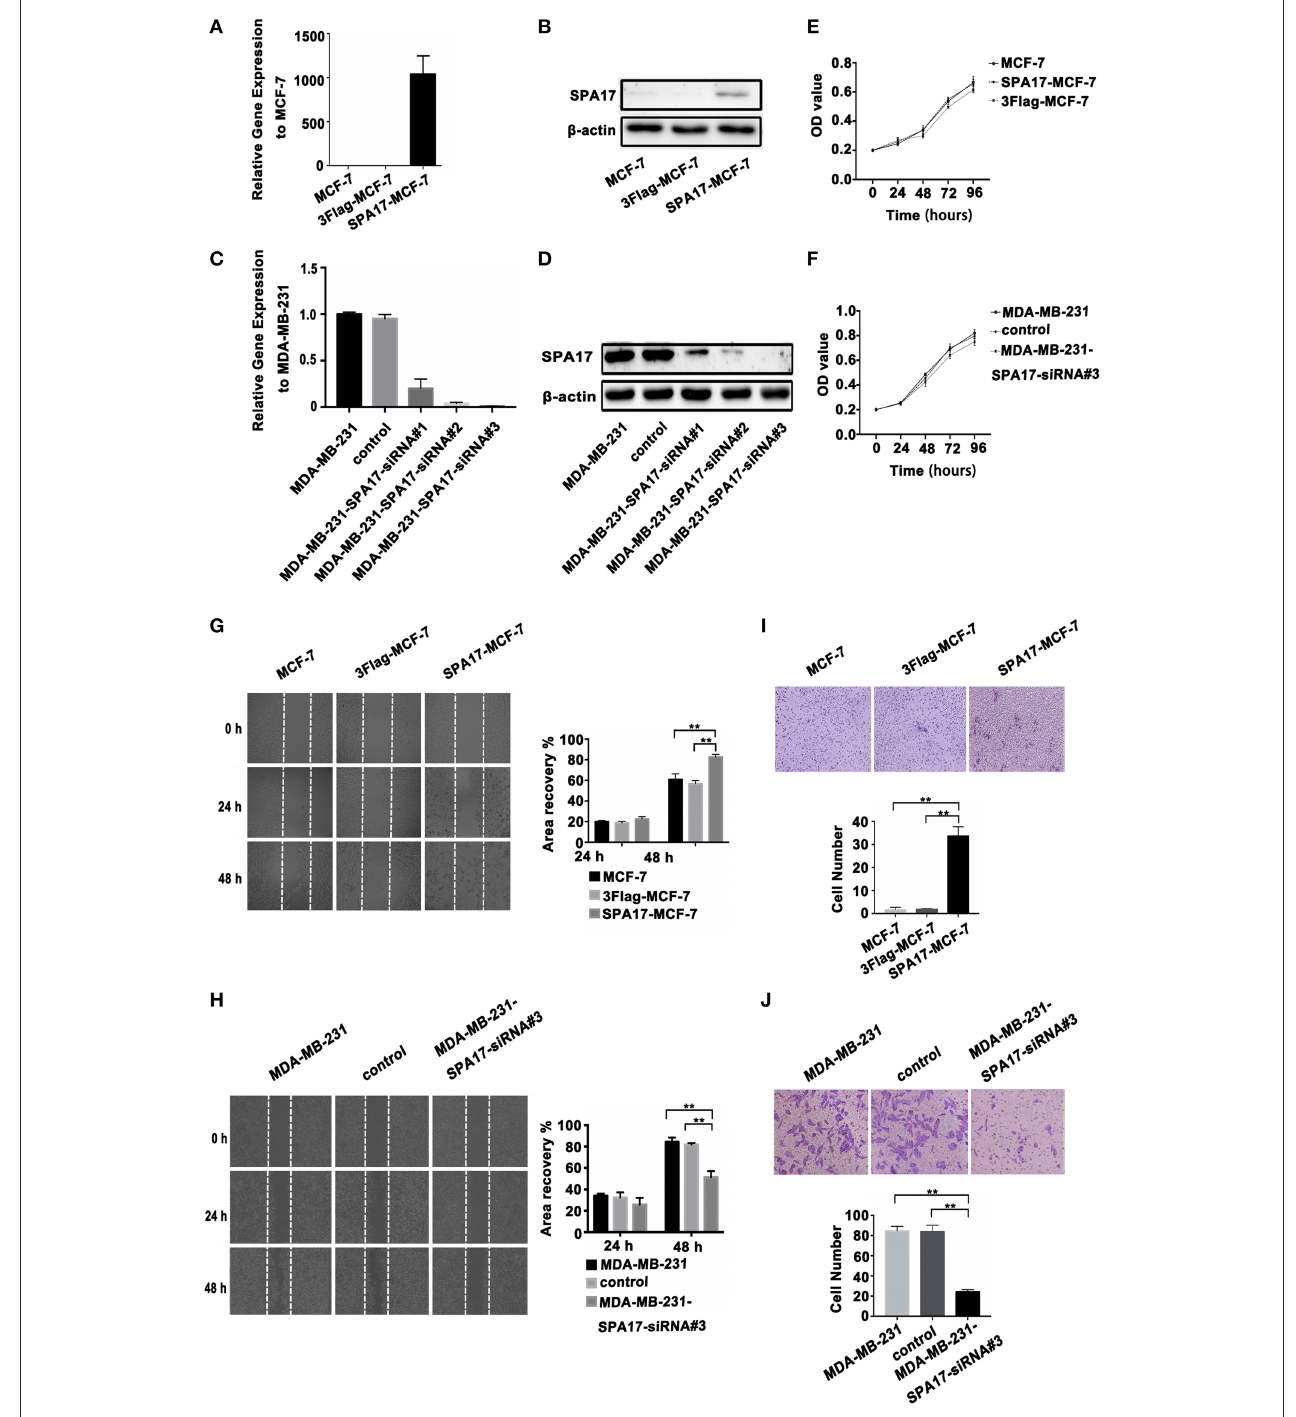
FIGURE 4 | (A,B) The overexpression of SPA17 gene and protein in SPA17-MCF-7 cells was confirmed by Q-PCR and Western-blot. (C,D) The silencing of SPA17 gene in MDA-MB-231 cells was confirmed by Q-PCR and Western-blot. (E,F) Analyses of cell growth curves using the MTT assay. (G) The migration of SPA17-MCF-7, 3Flag-MCF-7, MCF-7, (H) MDA-MB-231, control and MDA-MB-231-SPA17-siRNA#3 cells were measured with the wound-healing assay ( n = 3). After culturing for 24h and 48h, the cells were photographed at × 40; Samples were compared using one-way ANOVA, and error bars represent mean ± S.D. (I) The invasion of the SPA17-MCF-7, 3Flag-MCF-7, MCF-7, (J) MDA-MB-231, control and MDA-MB-231-SPA17-siRNA#3 cells were measured using the transwell assay ( n = 3). After culturing for 48h, the cells were stained with crystal violet solution and photographed at 200. Samples were compared using one-way ANOVA, and error bars represent mean ± S.D., * p < 0.05, ** p < 0.01.